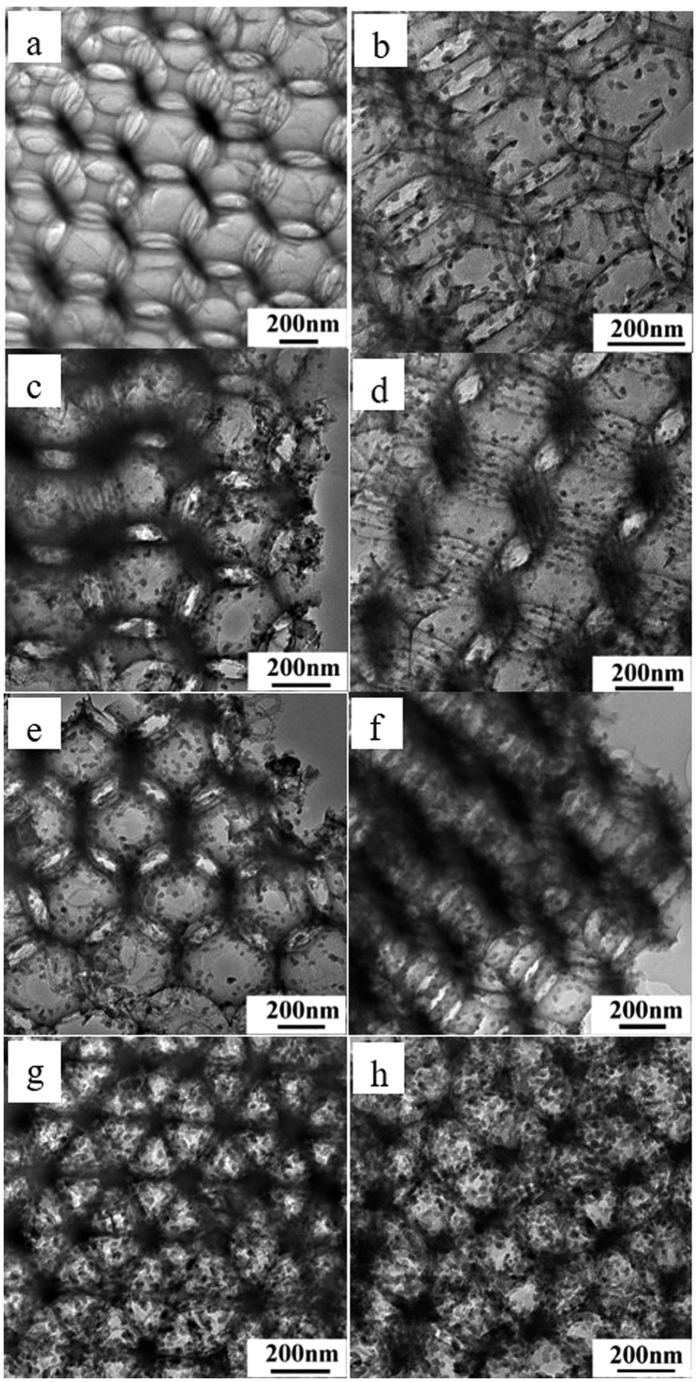
TEM images of 3DOM K-OMS-2/SiO2 catalysts.SiO2 (a); K-OMS-2/SiO2-10 (b); K-OMS-2/SiO2-20 (c); K-OMS-2/SiO2-30 (d); K-OMS-2/SiO2-40 (e); K-OMS-2/SiO2-50 (f); K-OMS-2/SiO2-60 (g); K-OMS-2/SiO2-70 (h).